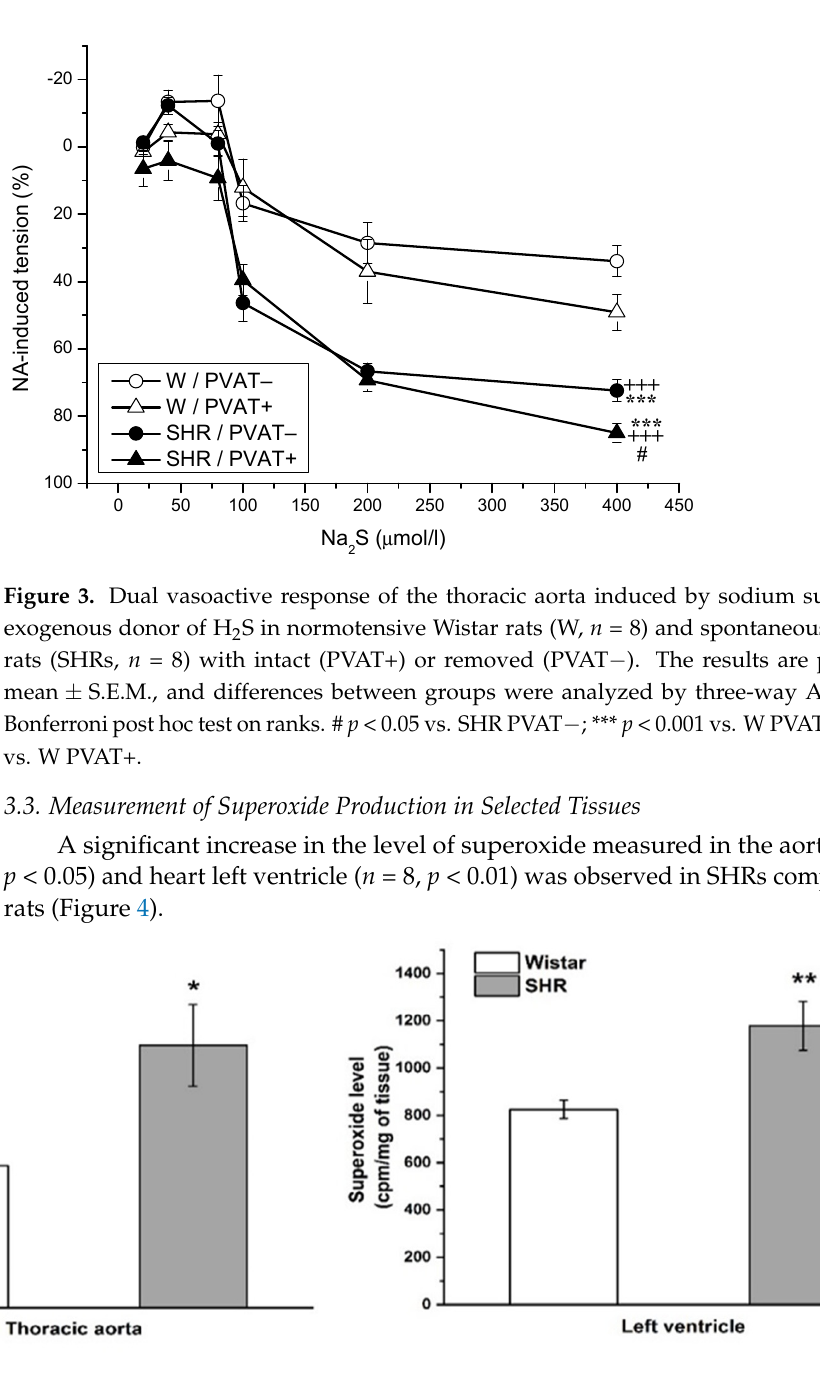
The protein expression of CSE was comparable between Wistar rats and SHRs in both tissues—thoracic aorta and PVAT (Figure